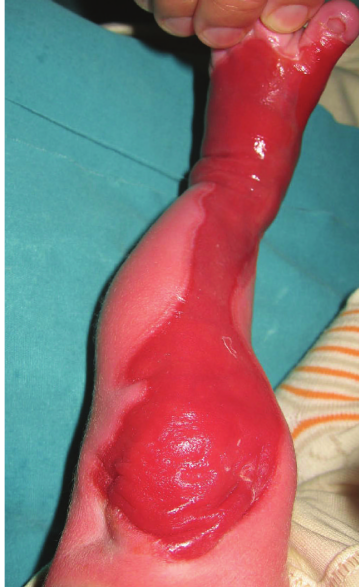
Figure 3: The view of the scars at the end of three-weeks (notice the milia